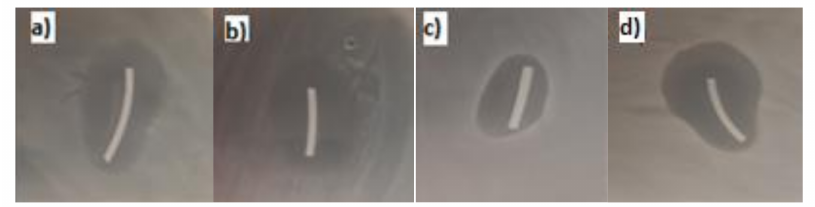
Figure 13. Selected photographs of inhibition zones of AMI-1 samples in bacteria growth ( a ) E. coli ( b ) P. fluorescens ( c ) S. aureus ( d ) S. epidermidis .